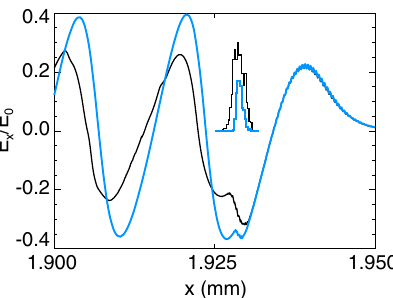
FIG. 9. Longitudinal electric field after injection of the electron bunch as a function of propagation distance for the parameters of Fig. 8 with a 1 ¼ 1 . 1 (black) and a 1 ¼ 0 . 4 (blue), and corre- sponding trapped bunch longitudinal